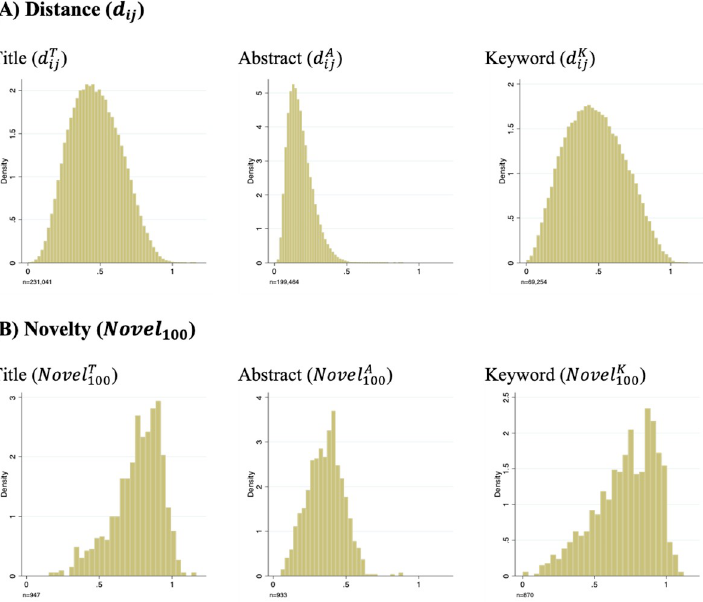
Fig 2. Distribution of distance and novelty. The same sample for the third validation study (prediction of future citation) is used, except that oversampled highly-cited documents are excluded. The 947 selected documents include in total approximately 230,000 combinations of cited references, for which the distance (Eq 1) is computed (A). The distances are summarized at the focal document level (Eq 2), and Novel 100 is displayed as an example (B). Novelty measures with different q values are illustrated in S1 Appendix. Since abstracts and keywords are not available for all documents, the sample sizes are